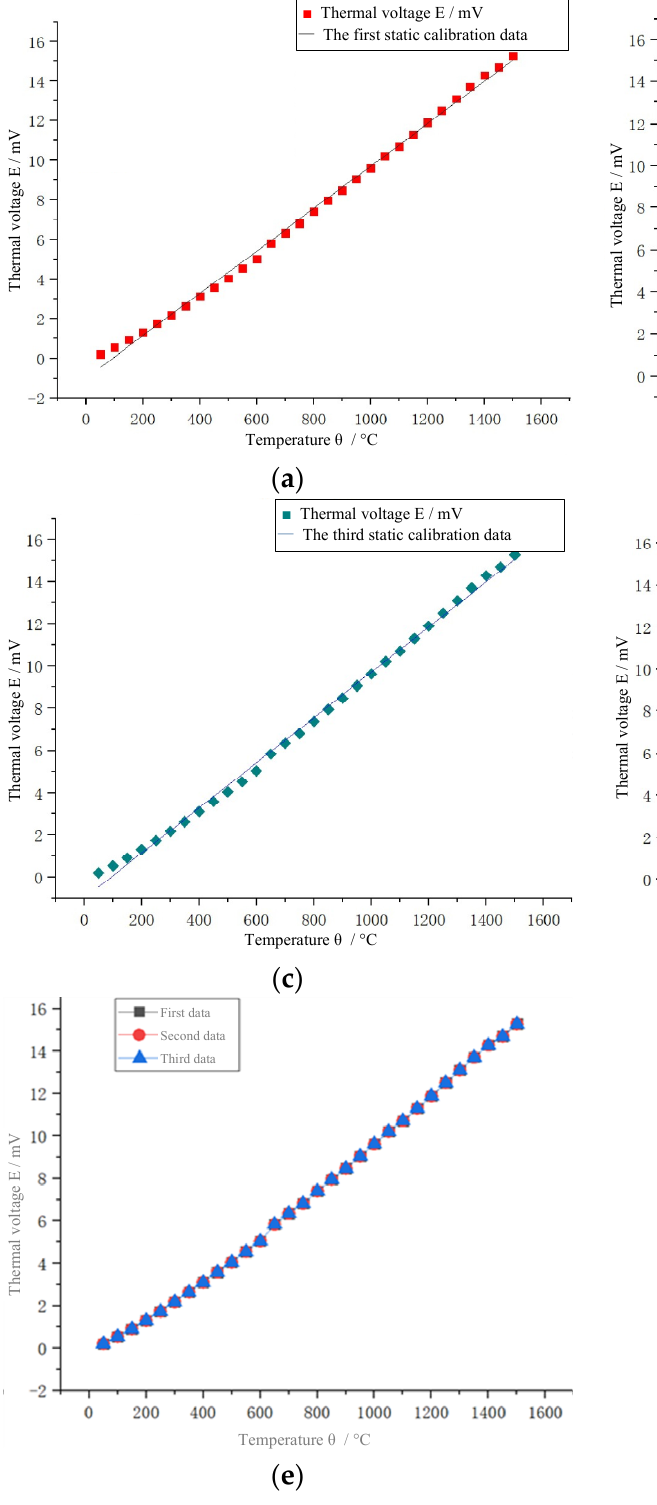
Figure 13. Data fitting of thin-film thermocouple after three calibration experiments: ( a ) First static calibration data fitting curve; ( b ) Second static calibration data fitting curve; ( c ) Third static calibration data fitting curve; ( d ) Mean fit curve for static calibration data; ( e ) Repeatability of data from three calibration experiments.